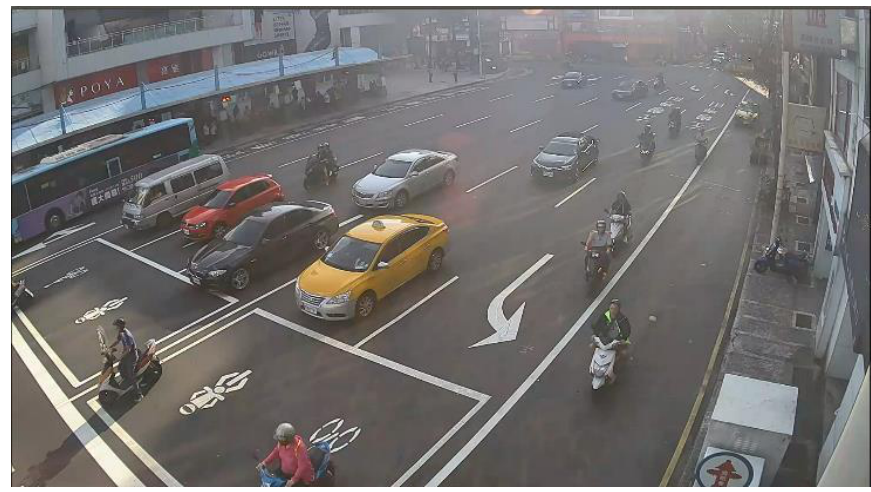
Figure 16. Glare scene: original image.